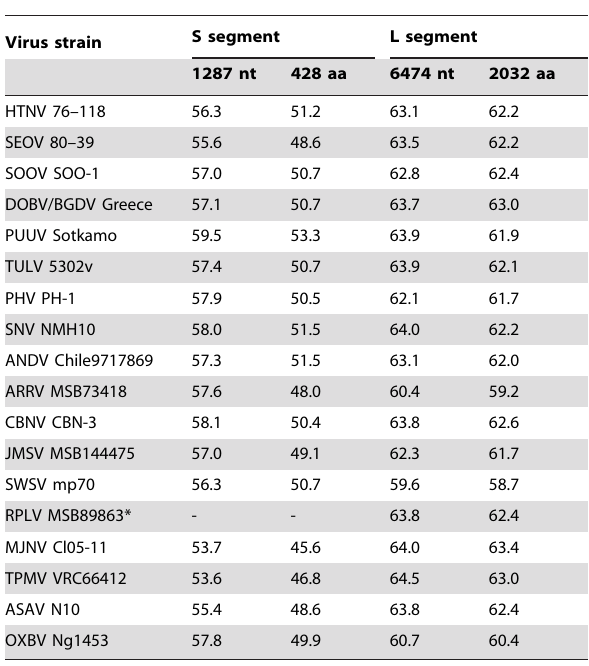
Table 1. Sequence similarities (%) of the coding regions of the full-length S and L segments of NVAV strain MSB95703 and representative rodent- and soricomorph-borne